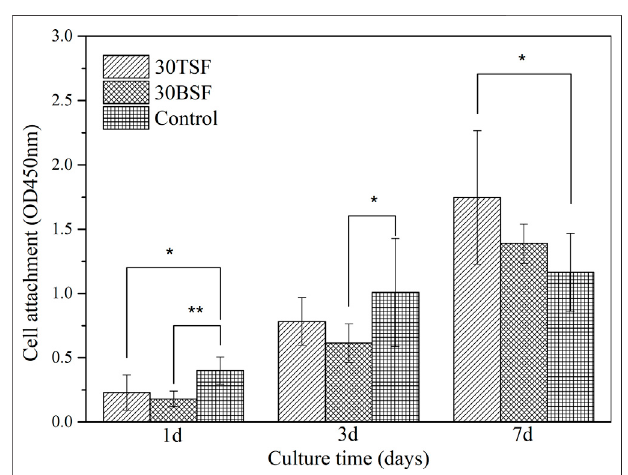
FIGURE 10 | CCK-8 test for the proliferation activity of NIH-3T3 on 30TSF, 30BSF, and control (* p < 0.05, ** p <